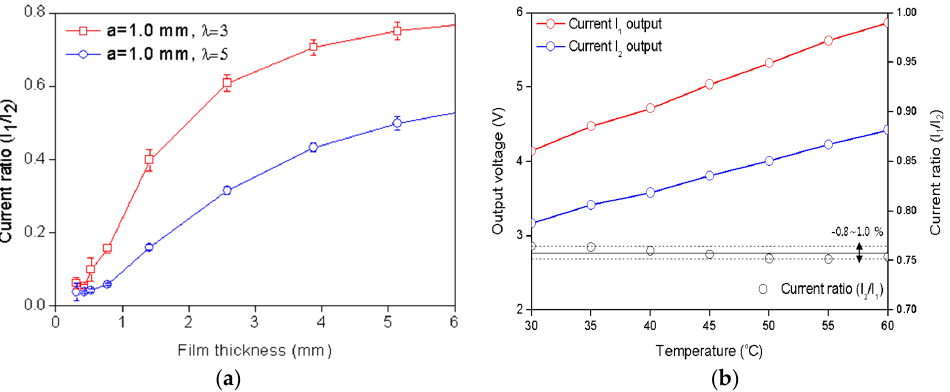
Figure 3. ( a ) current ratio with changes in the film thickness and electrode geometry; and ( b ) current output signal and current ratio at varying temperatures.